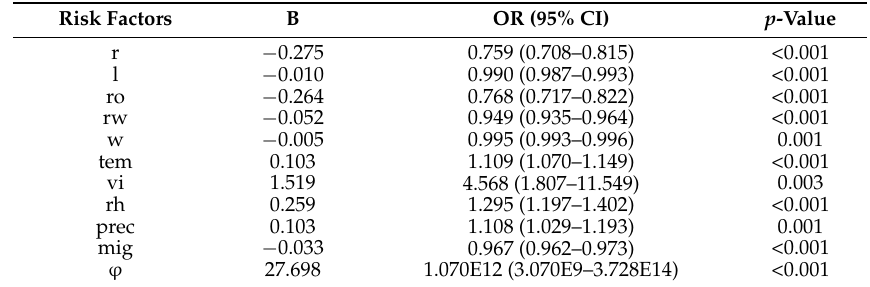
Table 4. Univariate analysis of risk factors for human infection with avian influenza A(H7N9) virus in China, March 2013–December 2014.